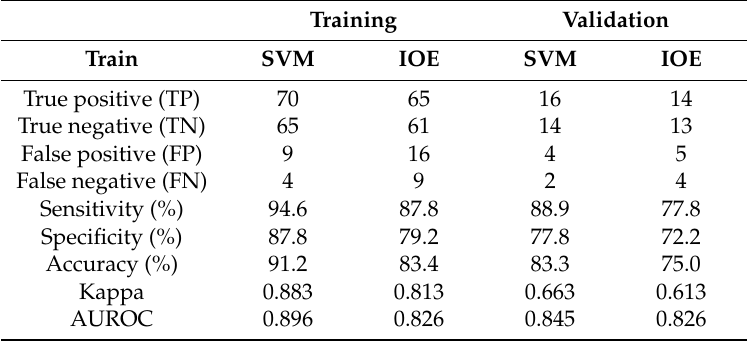
Table 4. Model performance on the training and validation datasets for the SVM and IOE models.